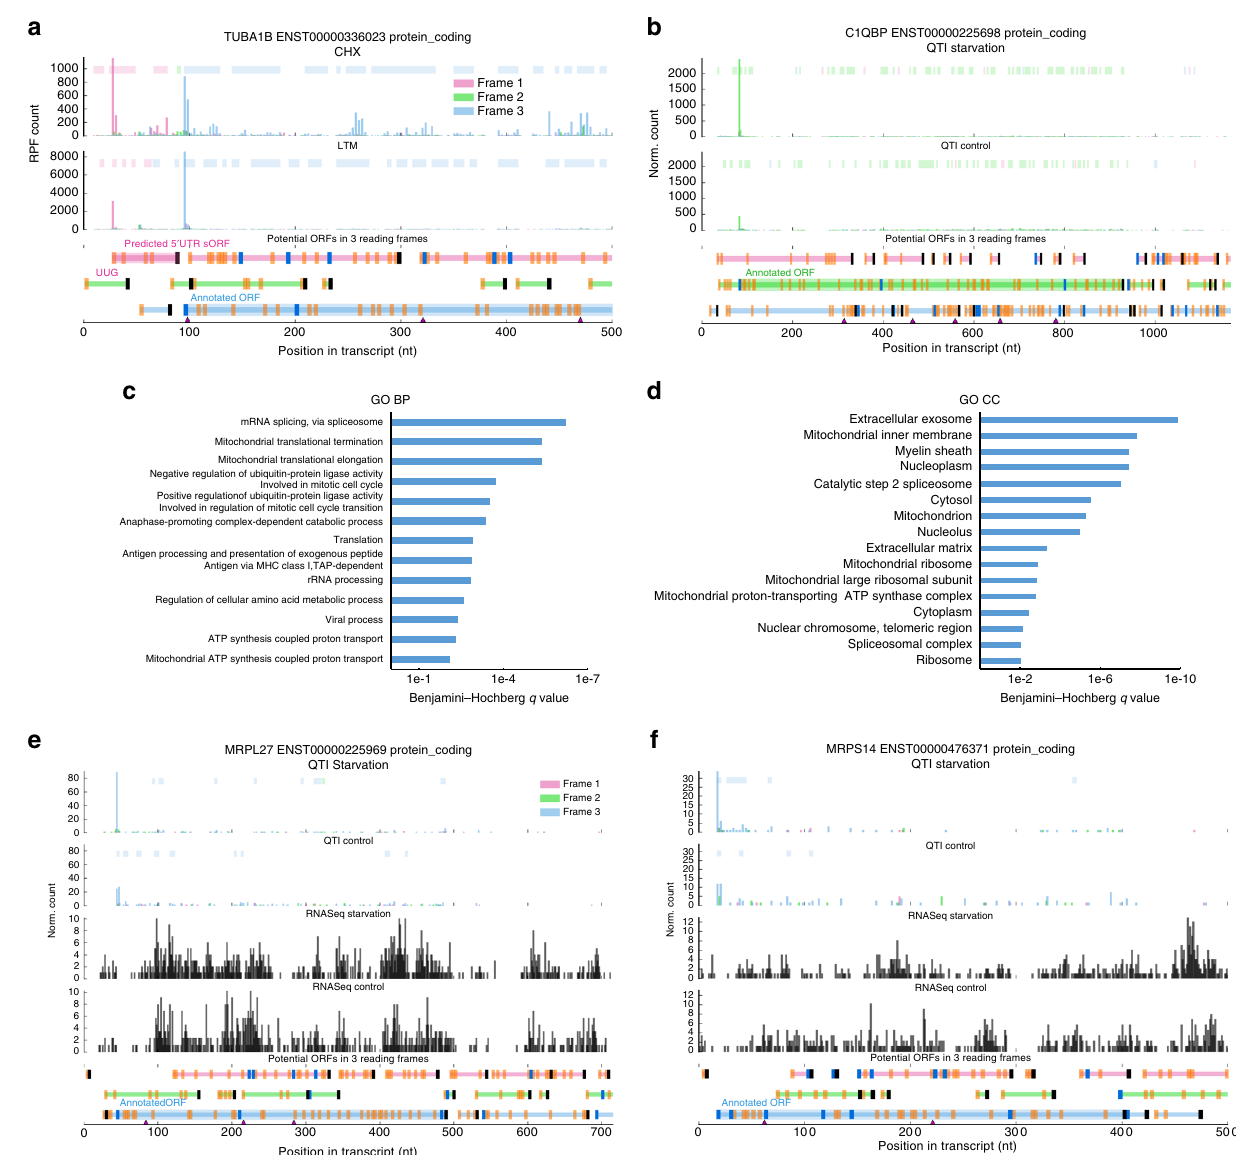
Fig. 4 Genome-wide identi fi cation and differential analysis of TIs. a rRibo-seq and LTM-based TI-seq RPF count pro fi les in HEK293 cell line for TUBA1B, suggesting a uORF being translated across a different reading frame (pink) from annotated one (skyblue). b The normalized QTI-seq RPF count pro fi les under normal condition and amino-acid deprivation for the longest isoform of C1QBP . The top enriched c biological processes and d cellular components, based on the GO enrichment analysis of the genes with signi fi cantly elevated translation initiation ef fi ciency under amino-acid deprivation. The normalized QTI-seq RPF and RNA-seq count pro fi les under normal condition and amino-acid deprivation for genes encoding mitochondrial ribosomal proteins e MRPL27 and f frame test based on the non-parametric Wilcoxon rank-sum test (Methods) to quantitatively assess the difference in read counts at individual CDS nucleotide positions between the candidate and alternative reading frames to predict the translated reading frame (Fig. 5a). To evaluate the performance of Ribo-TISH in predicting ORFs from rRibo-seq data, we performed an ROC analysis for Ribo-TISH and four other published methods: RiboTaper 40 ; ORF-RATER 41 ; riboHMM 42 ; and RibORF 12 using a published rRibo-seq data set 21 (Methods). Like Ribo-TISH, RiboTaper, ORF-RATER, and riboHMM can predict ORFs from rRibo-seq data without user-speci fi ed ORF candidates. RiboTaper was built upon the multi-taper method developed in the signal-processing fi eld. RiboTaper and Ribo-TISH use unsupervised methods that do not rely on prior knowledge of the ORF annotation and allow